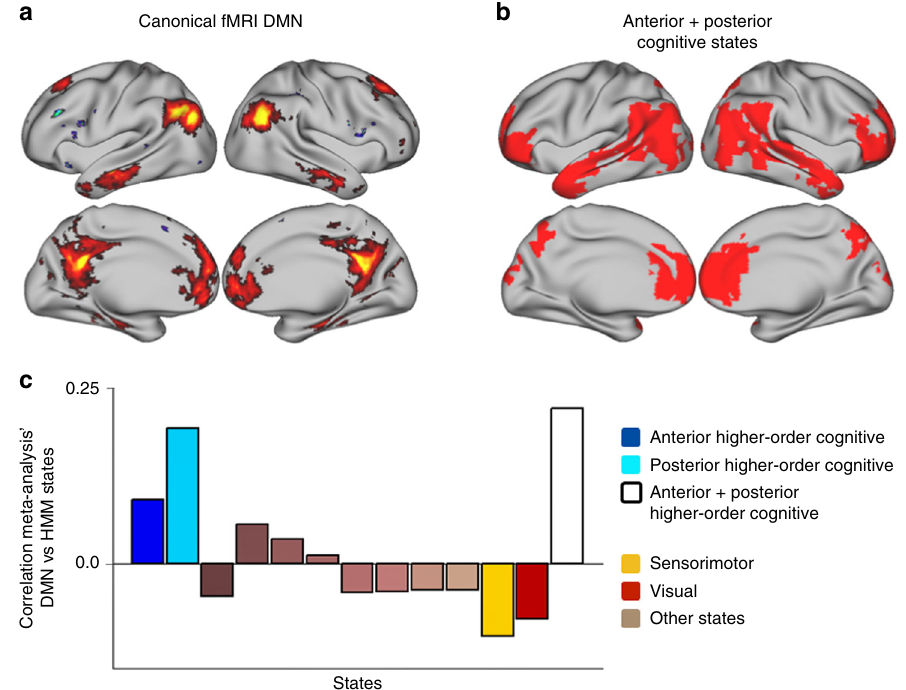
Fig. 6 The higher-order cognitive states correlate with the canonical fMRI DMN, according to a meta-analysis. a Canonical DMN derived from the fMRI literature. b Union of the two higher-order cognitive states (see the corresponding section in Results). c Correlation of each state to the canonical fMRI DMN; note that the far right bar, shown in white, corresponds to the union of the two higher-order cognitive states shown in